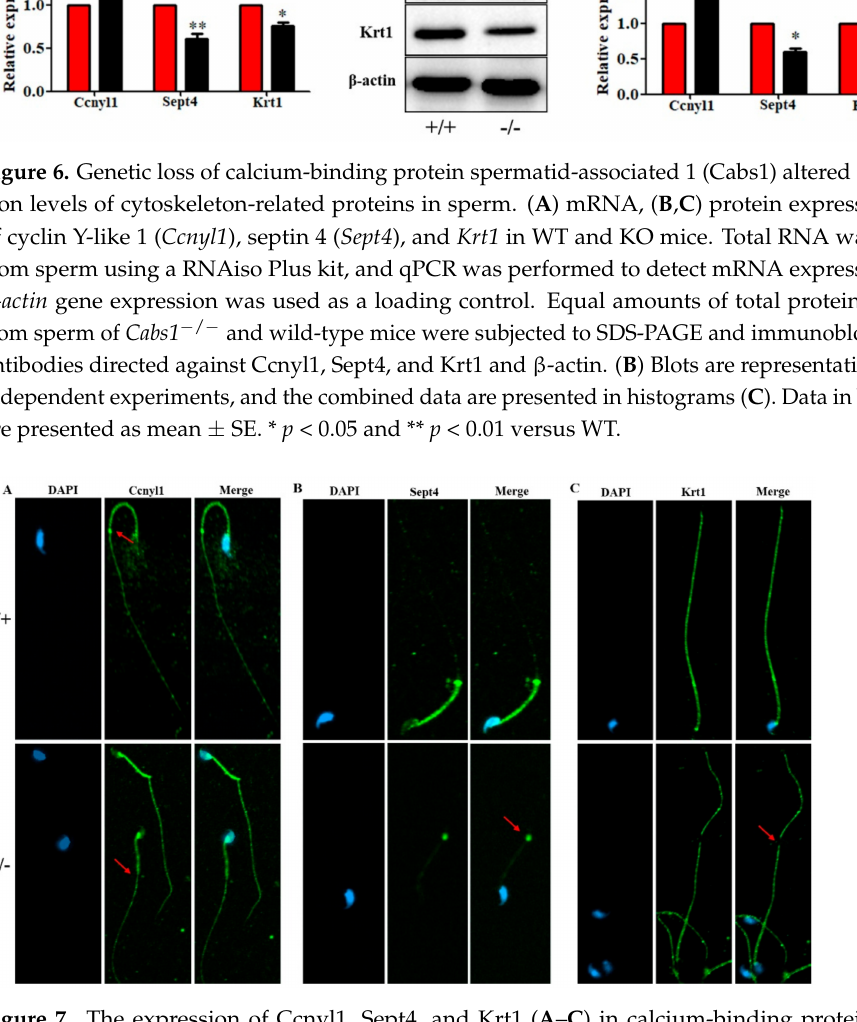
Figure 7. The expression of Ccnyl1, Sept4, and Krt1 ( A – C ) in calcium-binding protein sperma- tid-associated 1 knockout (Cabs1 − / − ) mice. Immunofluorescence labeling of mature sperm with cy-clin Y-like 1 (Ccnyl1), septin 4 (Sept4), and Krt1 antibodies, and nuclear staining with DAPI (4 (cid:48) ,6- Diamidino-2-Phenylindole, Dihydrochloride). Imaging was performed on a confocal micro-scope. Arrows indicate a protein loss in KO mice sperm flagella compared with